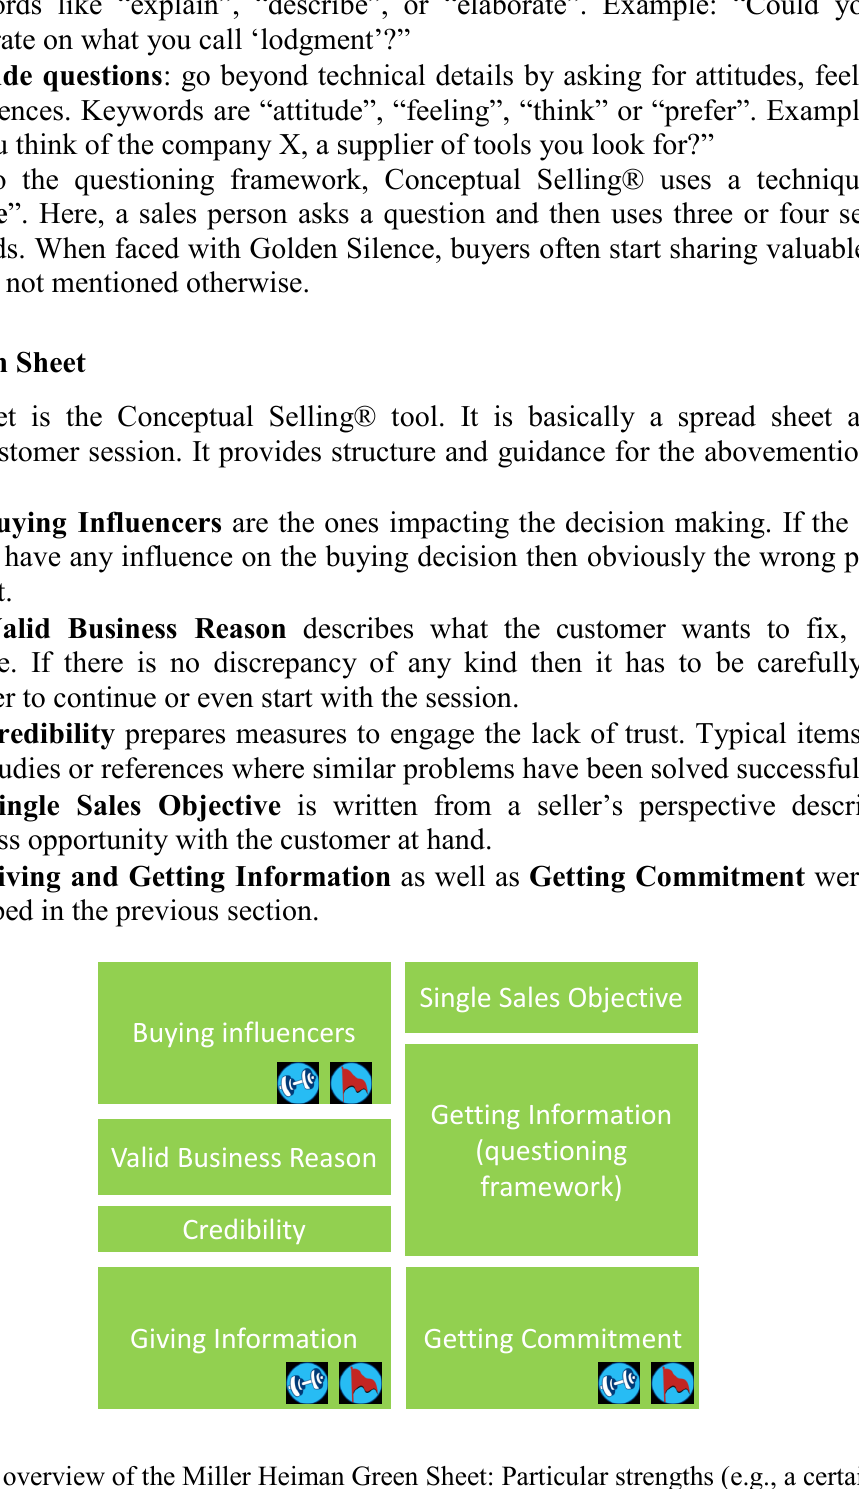
Figure 2. Section overview of the Miller Heiman Green Sheet: Particular strengths (e.g., a certain product feature meeting the customer’s need) are marked by weights while problems or difficulties (e.g., a certain customer attitude or behavior) are indicated using red flags. Especially red flags have to be